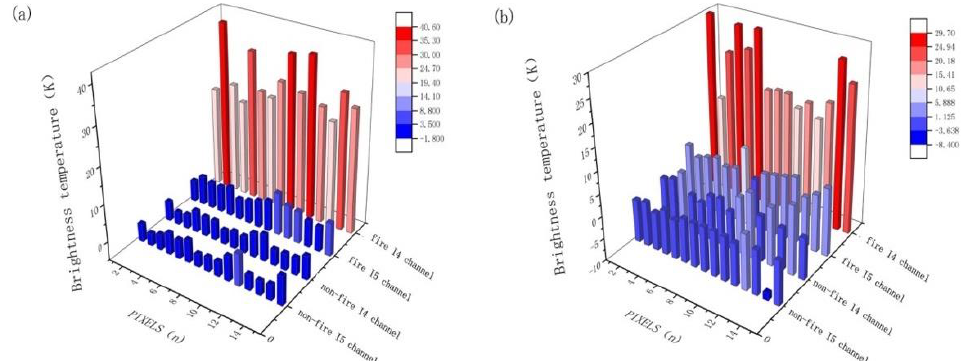
Figure 2. Comparison of differences in the spatial distribution of brightness temperatures between pixel channels I4 and I5 when 15 typical samples were selected. Contextual comparison between channels I4 and I5 of some fire and non-fire pixels ( a ) in winter; ( b ) is summer. The x -axis is the number of sampled pixels, and the y -axis represents the difference in brightness temperature between the potential fire and the effective adjacent pixels in the window.